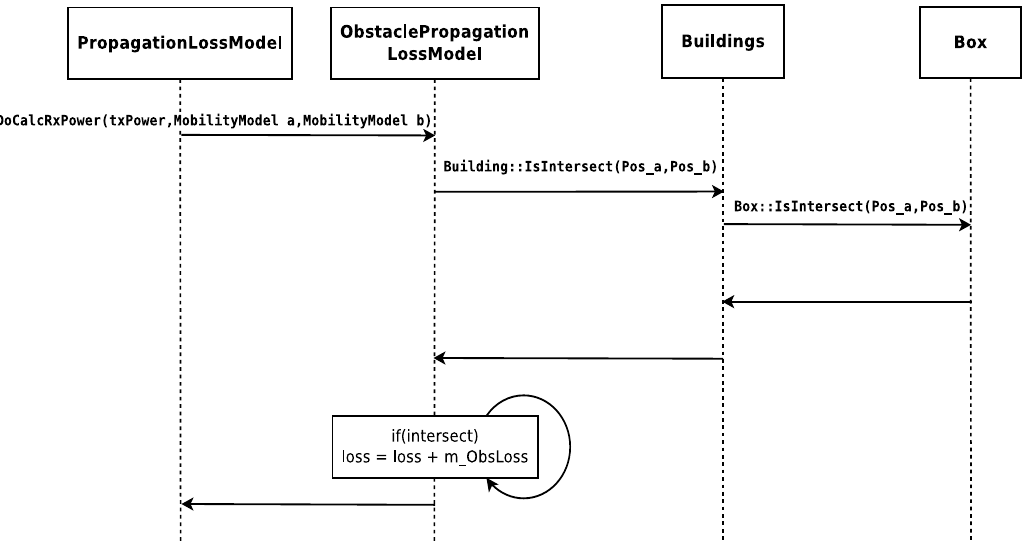
Figure 1: Sequence diagram for calculating obstacle Path